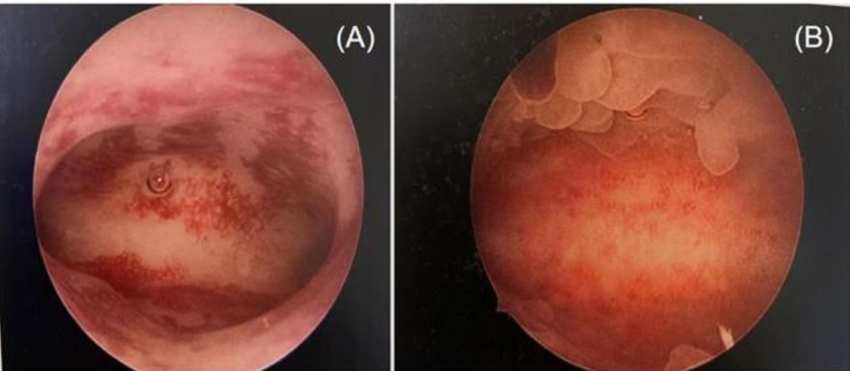
Figure 1. Different features of chronic endometritis at hysteroscopy: ( A ) diffuse hyperemia en- dometrium; ( B ) micropolyps (less than 1 mm in